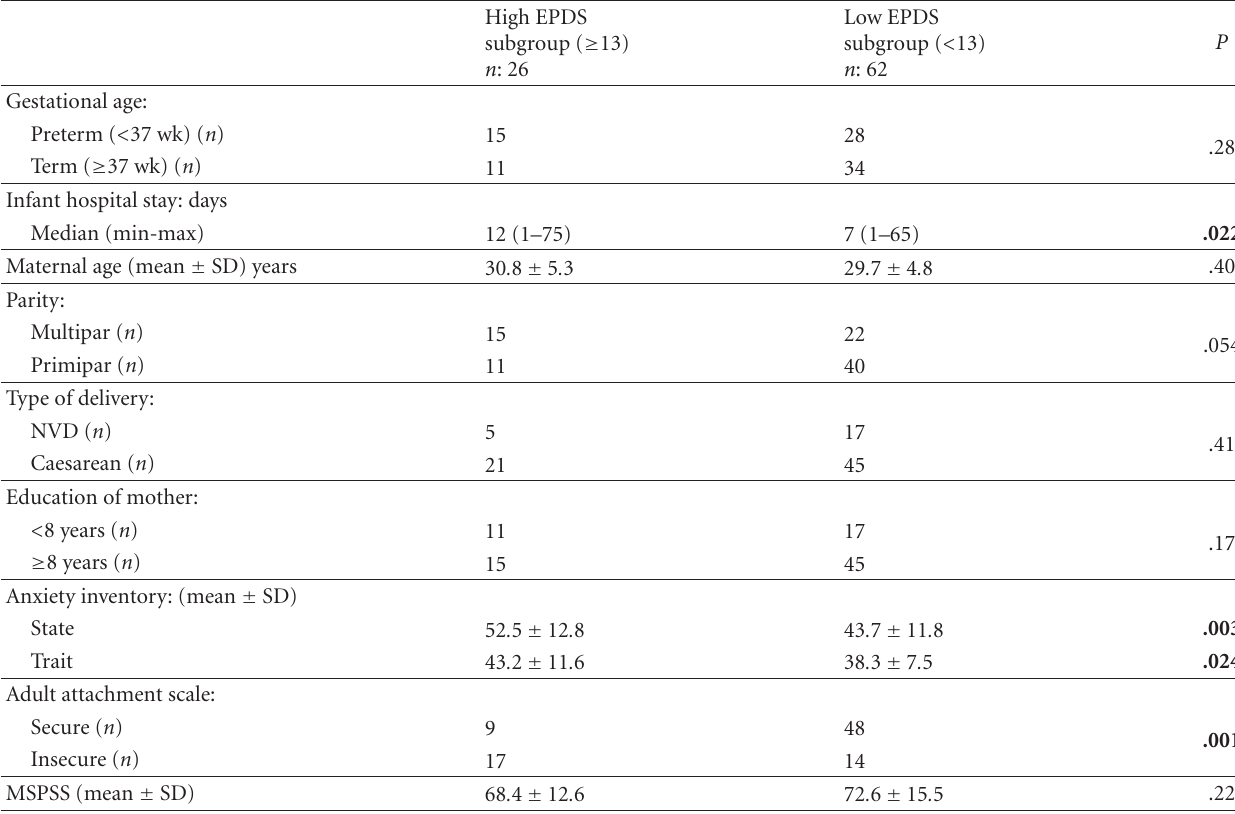
Table 4: Psychological adjustment and demographic characteristics of NICU subgroups mothers according to the EPDS scores. High EPDS